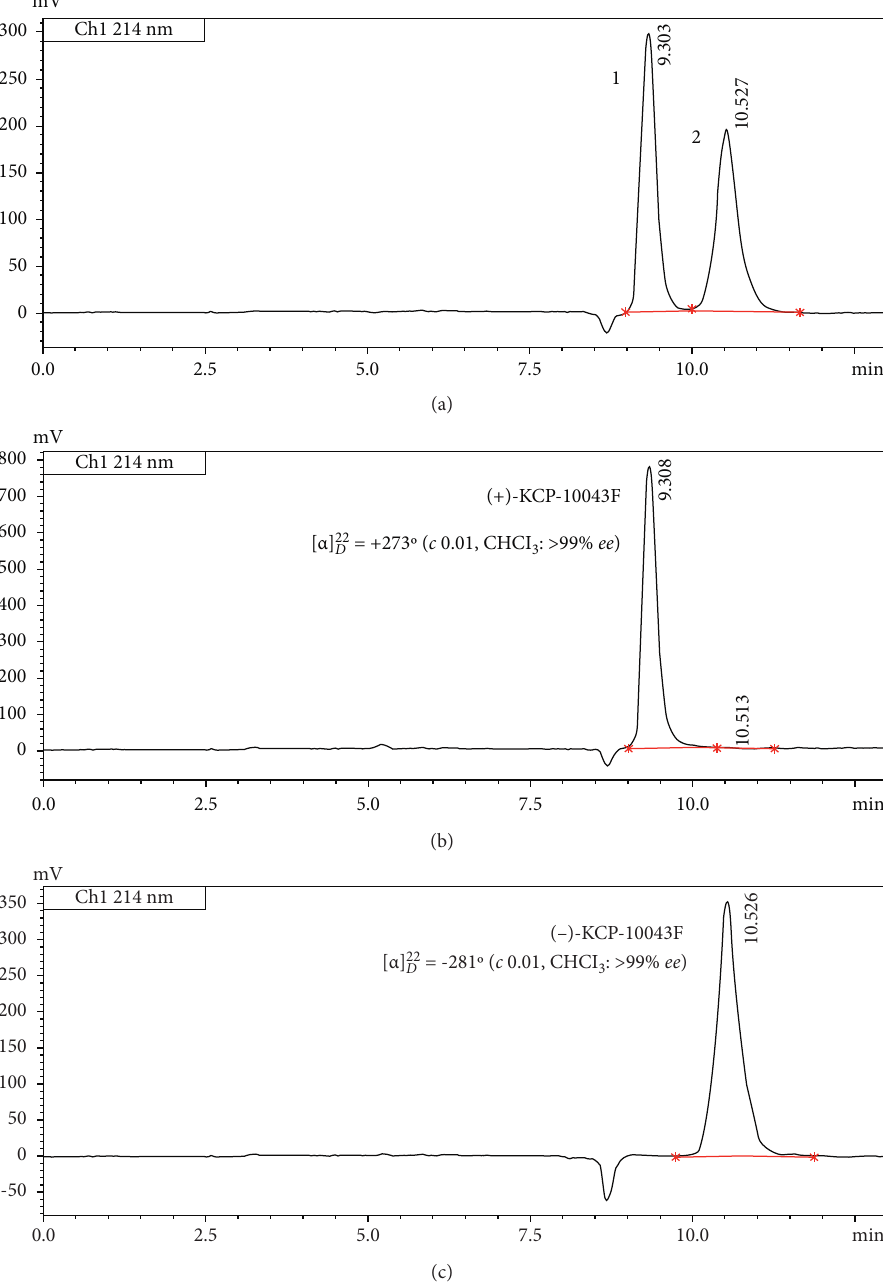
(Supplemental data: Figure S4). The (+)- KCP-10043F ( OZ-